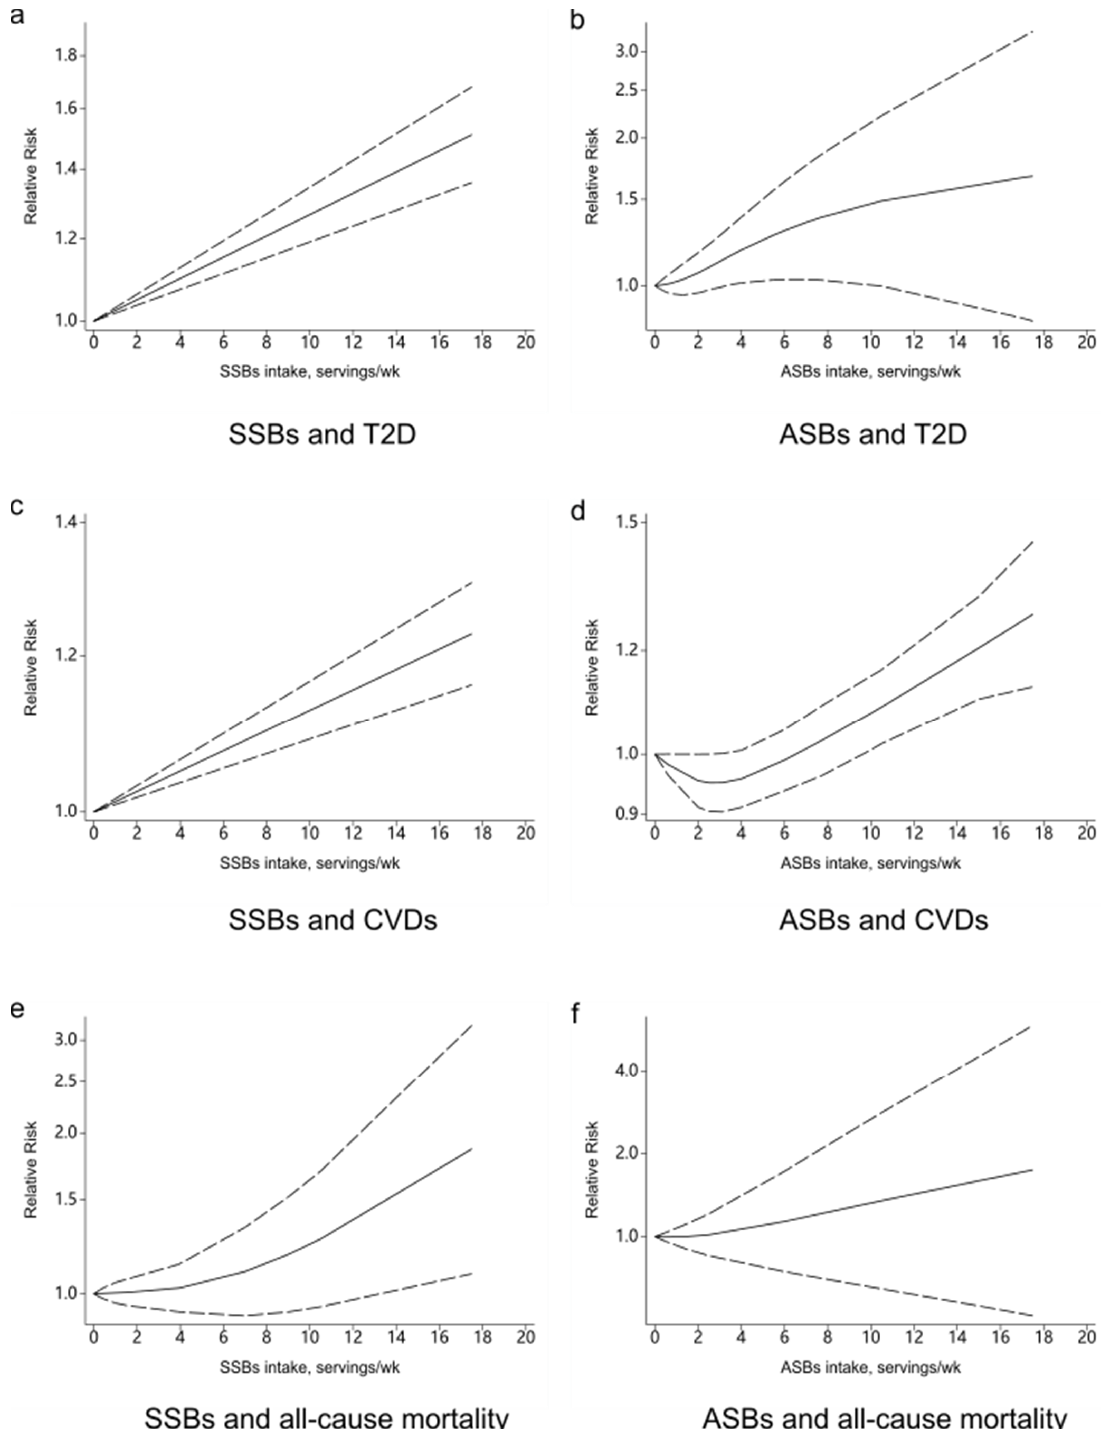
Figure 6. Dose-response relationship between sugar-sweetened beverages and artificially sweetened beverages consumption with the risk of type 2 diabetes, cardiovascular diseases, and all-cause mortality. ( a ) Dose-response relationship between SSBs and T2D. ( b ) Dose-response relationship between ASBs and T2D. ( c ) Dose-response relationship between SSBs and CVDs. ( d ) Dose-response relationship between ASBs and CVDs. ( e ) Dose-response relationship between SSBs and all-cause mortality. ( f ) Dose-response relationship between ASBs and all-cause mortality. SSBs, sugar-sweetened beverages; ASBs, artificially sweetened beverages; T2D, type 2 diabetes; CVDs, cardiovascular diseases.